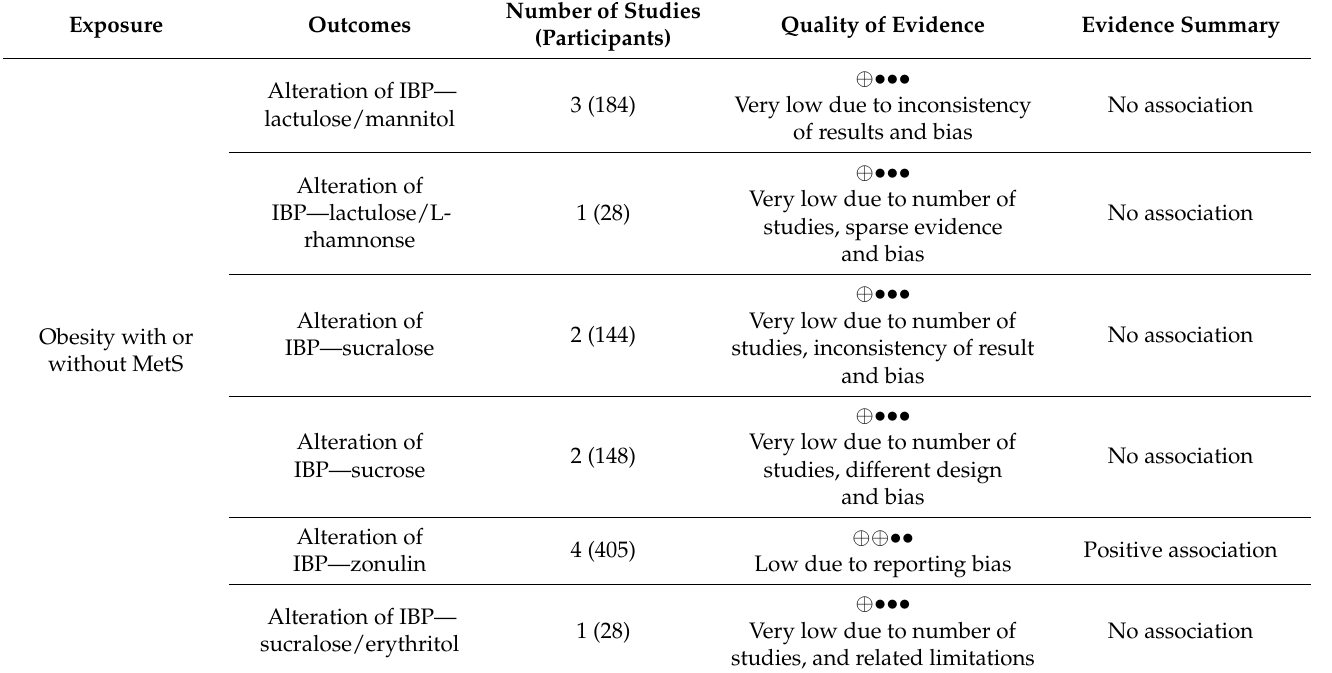
Table 3. Summary of evidence of the associations between obesity with or without MetS and intestinal barrier permeability (IBP) evaluated for each IBP